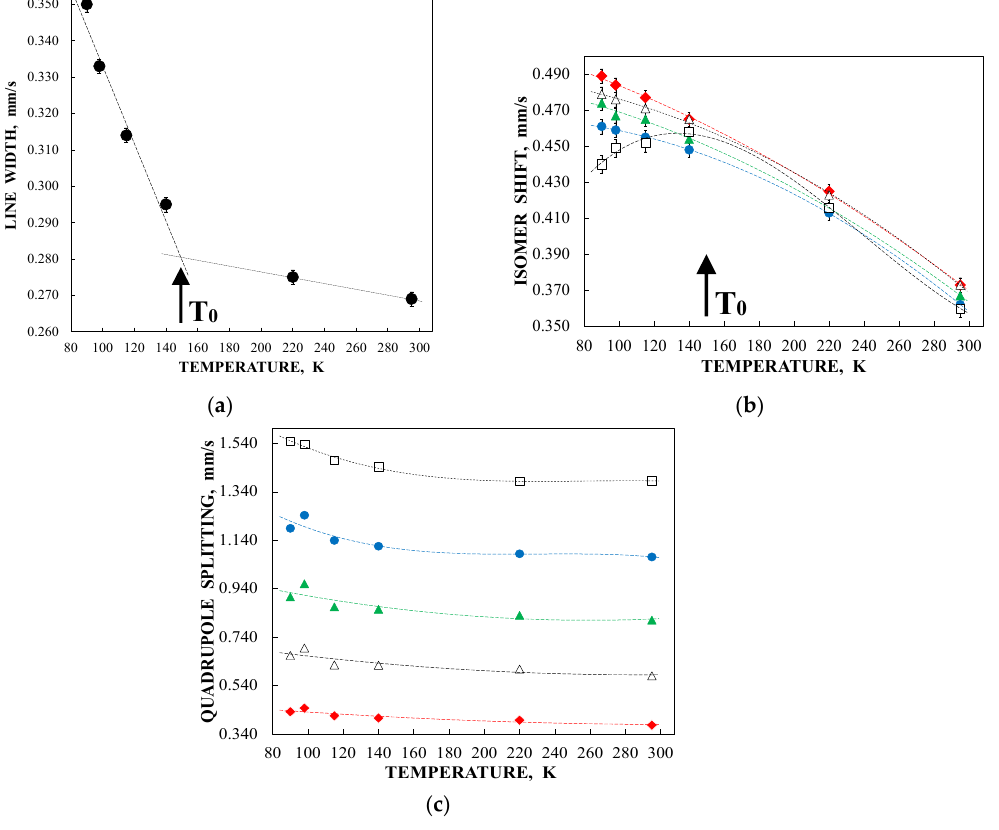
Figure 7. Temperature dependencies of: ( a ) the line width ( • is the line width for components 1–5, dashed lines indicate two different slopes before and after critical temperature T 0 ), ( b ) isomer shift and ( c ) quadrupole splitting for components 1–5 revealed in the ferritin Mössbauer spectra ( ♦ is component 1, △ is component 2, ▲ is component 3, • is component 4 and □ is component 5; dashed lines are polynomial approximations). Adapted from Ref. [49] with permission from